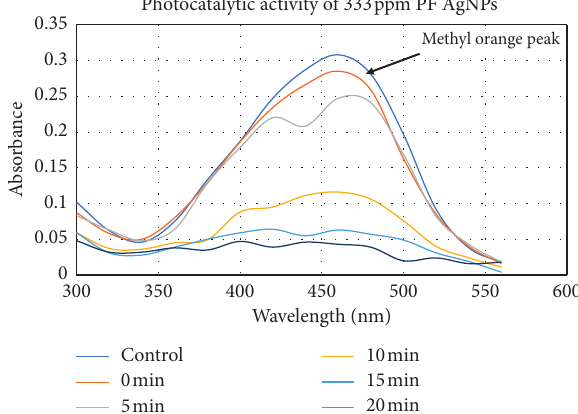
Figure 27: Absorbance of methyl orange with time when 333ppm PF AgNPs were